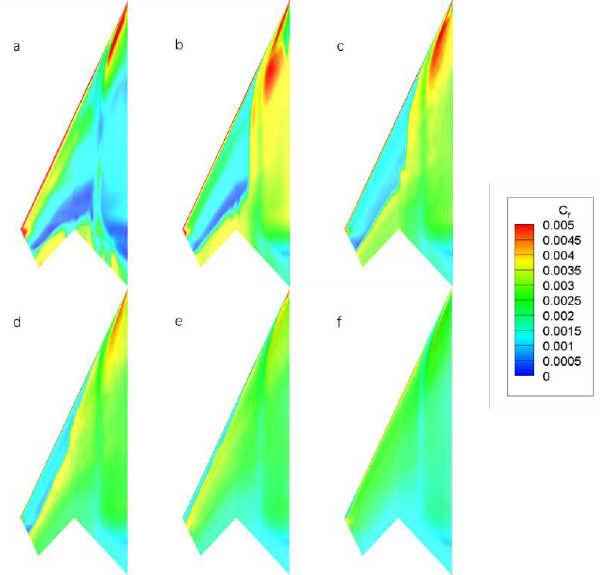
Figure 8. Friction coefficient distributions on the lower surface of the flying wing model with different Reynolds numbers ( M = 0.9, α = 2°, T u = 0.1%): ( a ) Re = 1 × 10 6 ; ( b ) Re = 2 × 10 6 ; ( c ) Re = 5 × 10 6 ; ( d ) Re = 10 × 10 6 ; ( e ) Re = 20 × 10 6 ; ( f ) Re = 80 × 10 6 .